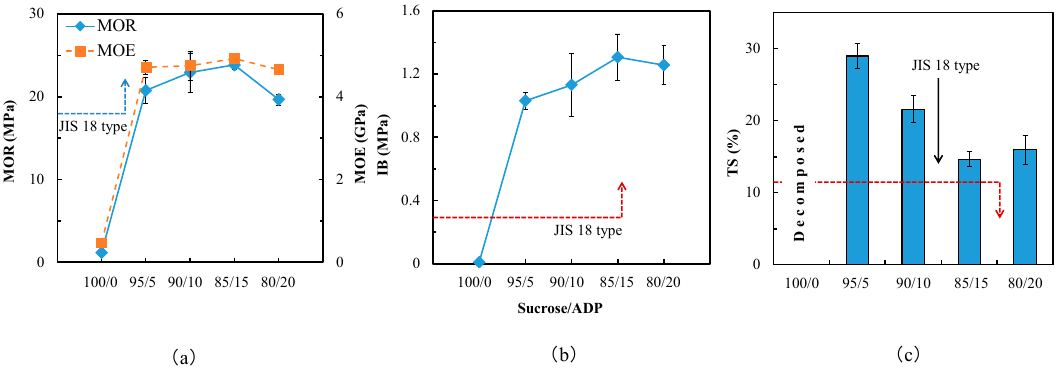
Figure 1. Properties of the particleboards bonded with SADP adhesives at different proportions. ( a ) Bending properties; ( b ) Internal bonding strength; ( c ) Thickness swelling. Error bars indicate the standard deviations.